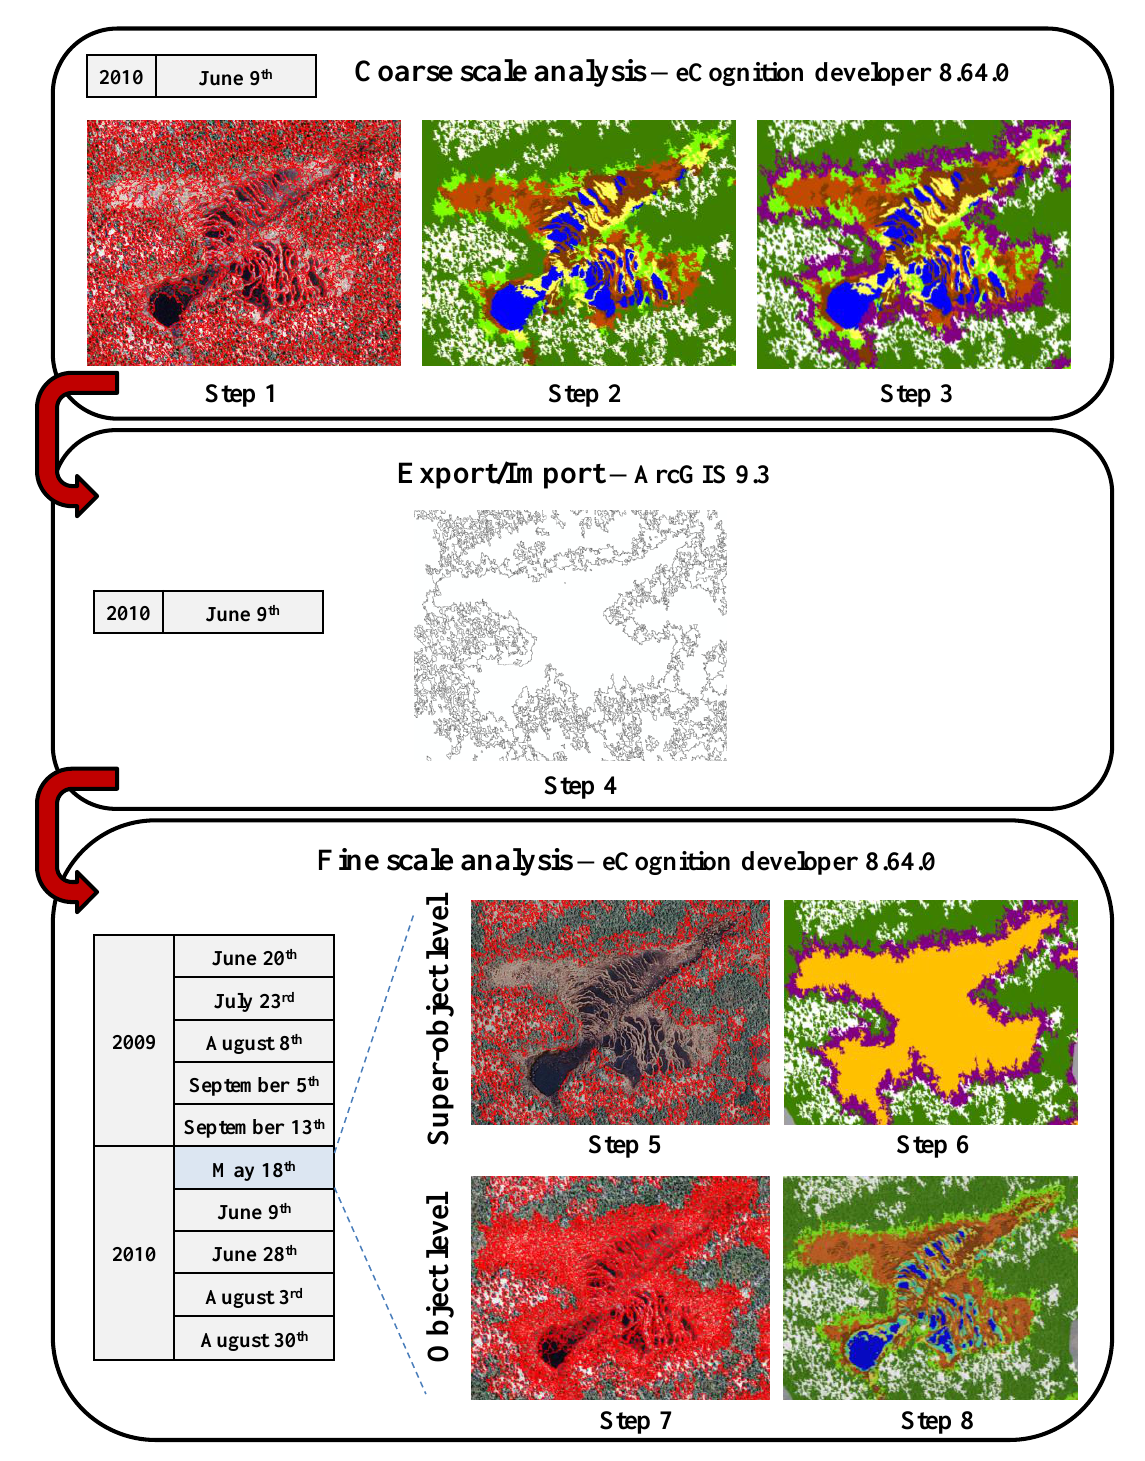
Figure 4. Scheme of the object-based analysis procedure.